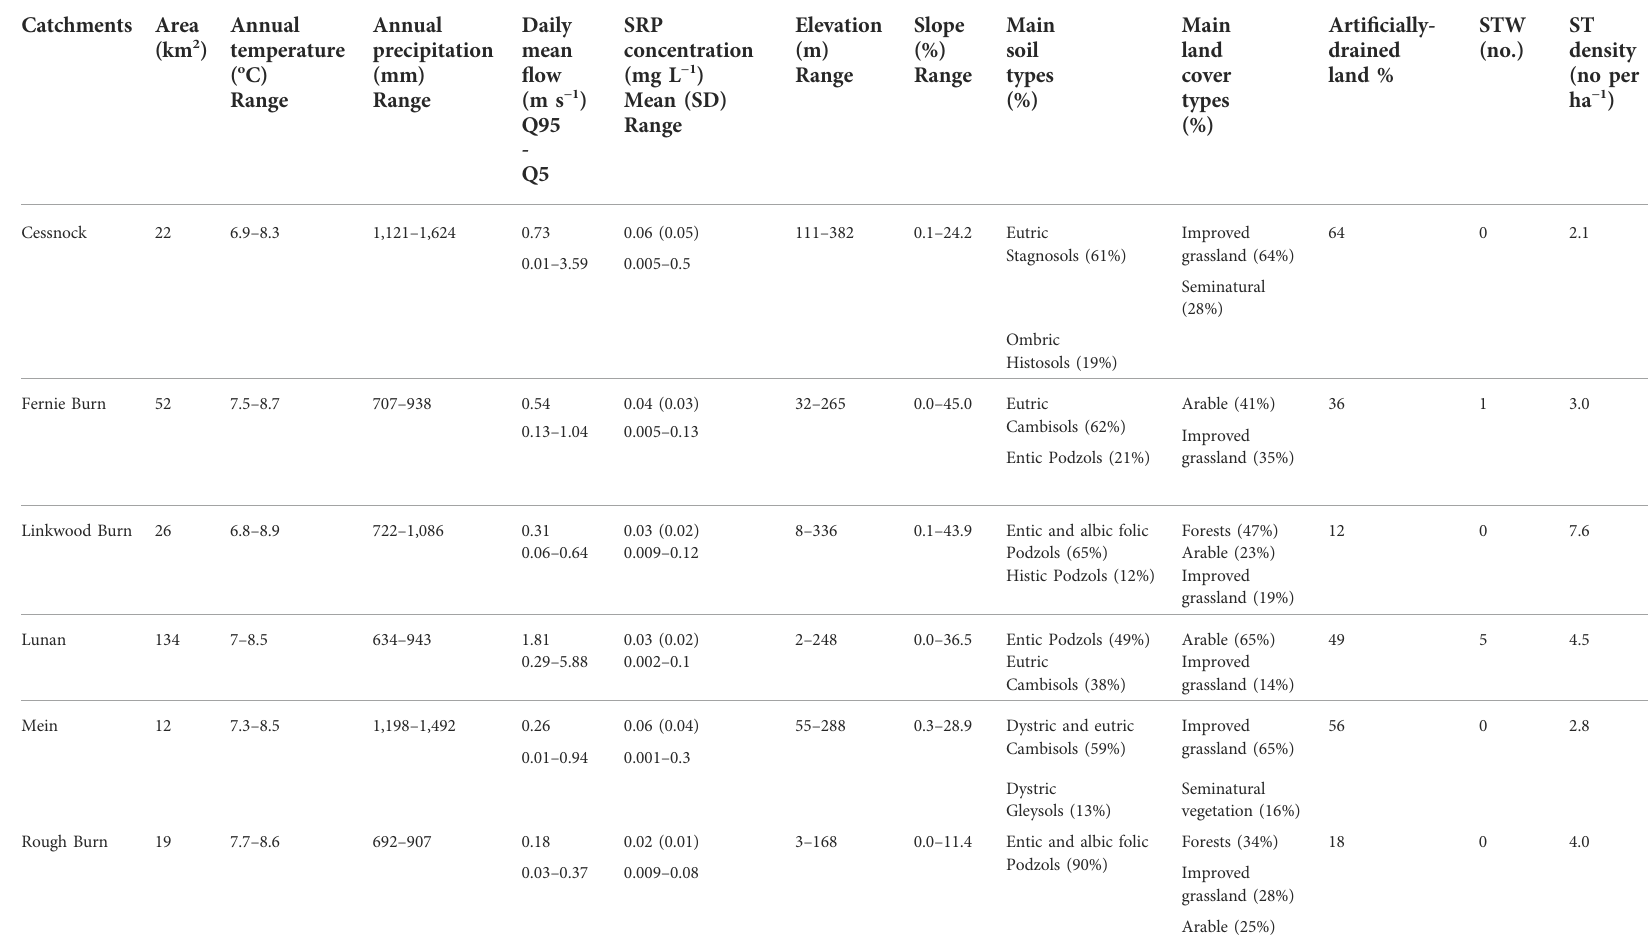
TABLE 1 Study catchment summary characteristics (mean, standard deviation and range (minimum-maximum)). Annual temperature and precipitation ranges within catchments are for the 1981 – 2010period. STW – sewagetreatmentworks, ST – individual domestic septictanks.Soiltypes basedonWorldReference Base(WRB) (FAO,2015).Percentage ofassumed tobe arti fi cially-drained land was based on Lilly et al.